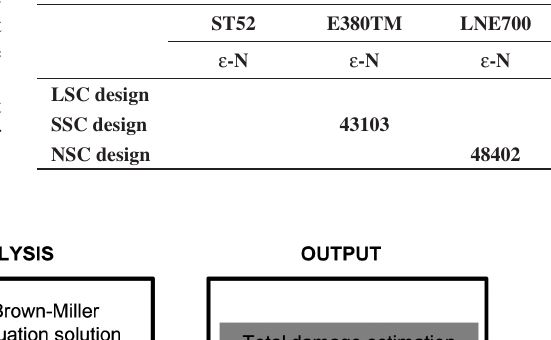
Table 2. Fatigue calculation life results for the three designs as number of laps to fail.